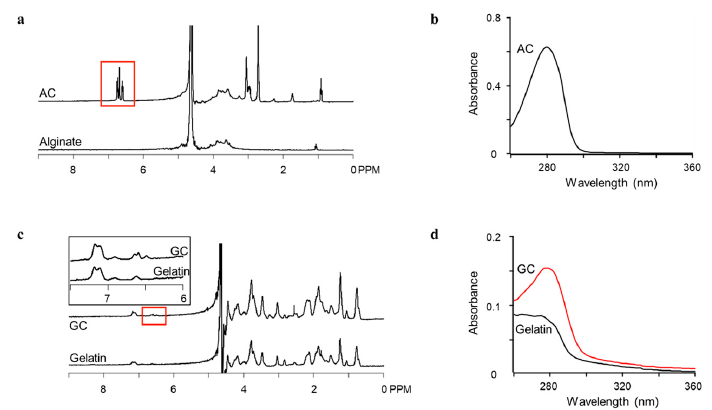
Figure 1. 1 H nuclear magnetic resonance (NMR) analysis of ( a ) Alginate-catechol (AC) and ( c ) Gelatin- catechol (GC), the inset in ( c ) shows the enlarged spectra from 6 to 7.5 ppm. Ultraviolet-visible (UV– vis) spectra of 0.25 mg/mL AC ( b ) and 1 mg/mL GC and gelatin ( d ). Table 1. Composition of dopamine-modified polymers.